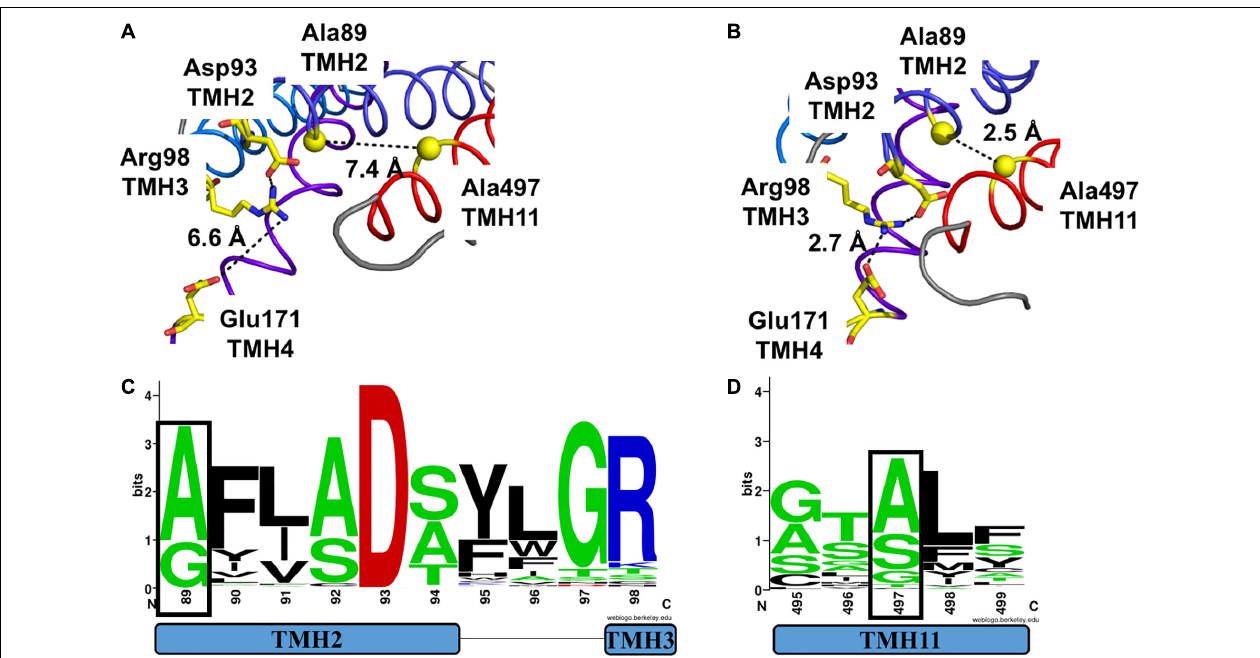
FIGURE 6 | Comparison of packing of TMH2 and TMH11 in MtNPF1.7 models in two different conformations and logo of conservation of the residues needed for packing. Comparison of the conformation of residues belonging to Motif A in the (A) I o conformation and (B) O o conformation. Ala89 and Ala497 are shown as spheres corresponding to their Ca atoms. Side chains for Asp93, Arg98, and Glu171 are shown as sticks. Broken lines indicate the distance between the closest atoms and possible polar contacts when distance is under 3.6 Å. (C) Logo of the conservation of amino acids in Motif A with residue +1 (corresponding to Ala89 in MtNPF1.7) in a black box. (D) Logo of the conservation of amino acids in TMH11 with Ala497 in a black box. See Figure 4 for